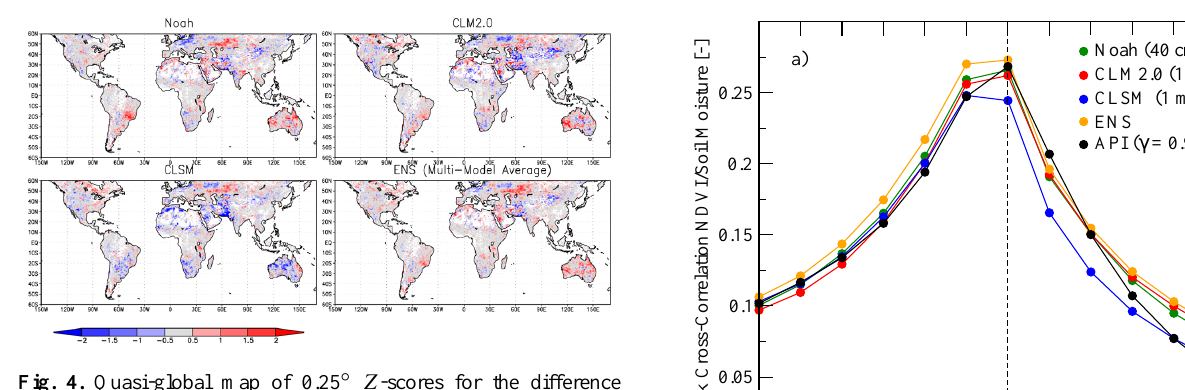
Fig. 4. Quasi-global map of 0.25 ◦ Z -scores for the difference R( − 1 ) LSM minus R( − 1 ) API where LSM estimates are obtained from Noah, CLM2.0, CLSM, and ENS.